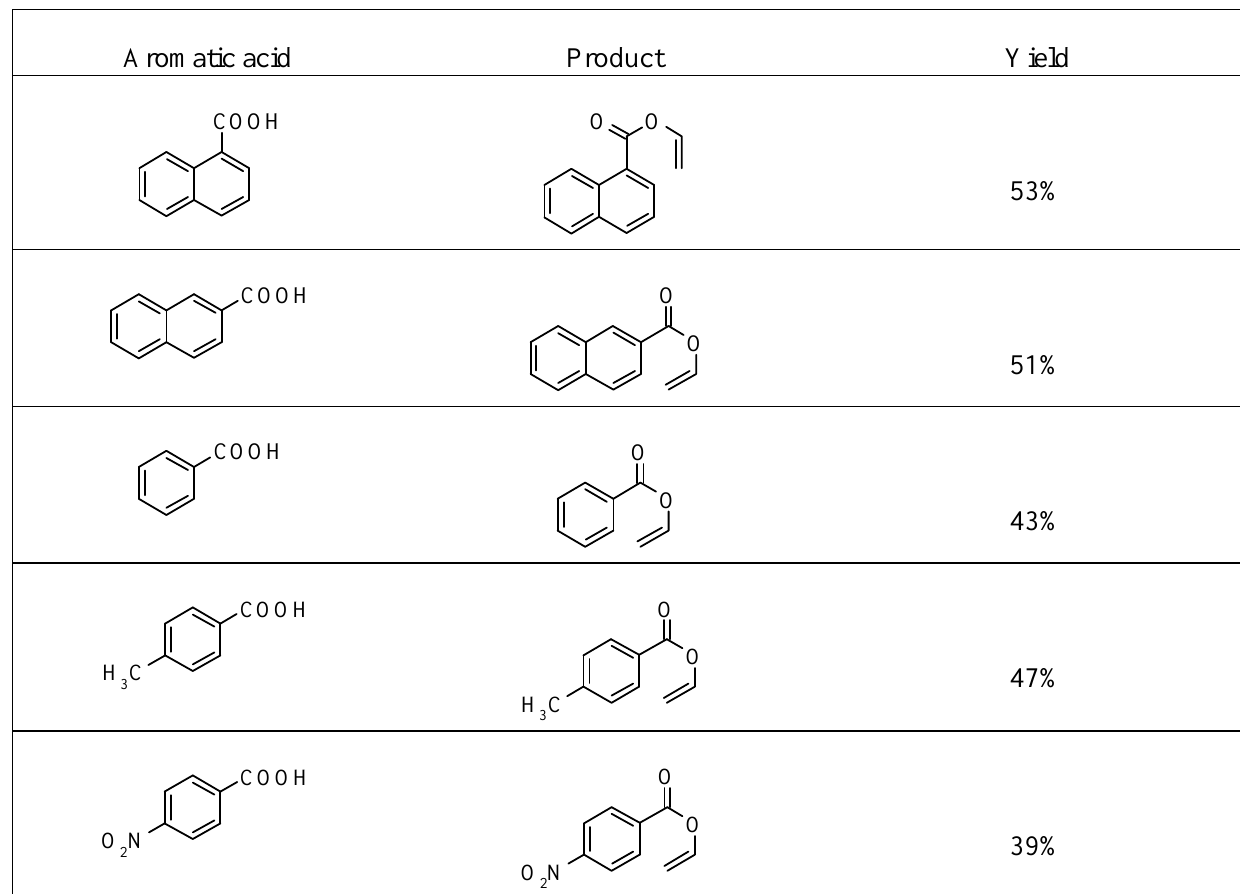
Table 1. The structure and yields of aromatic vinyl esters produced by palladium catalyzed reactions of aromatic acids and vinyl